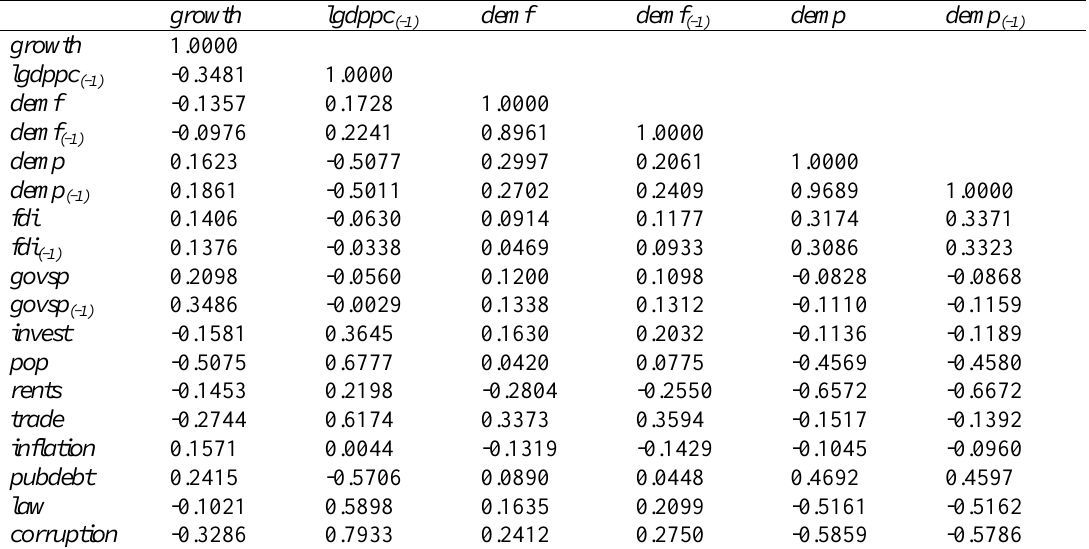
Table A.3: Correlation